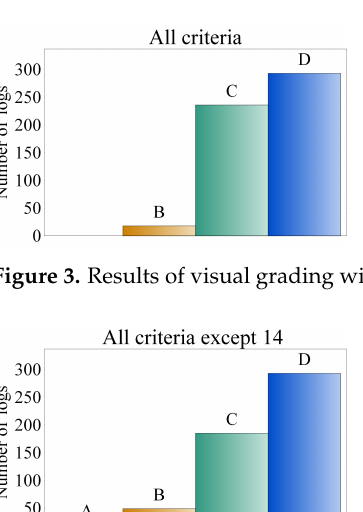
Figure 2. Results of visual grading by criteria (1–17).